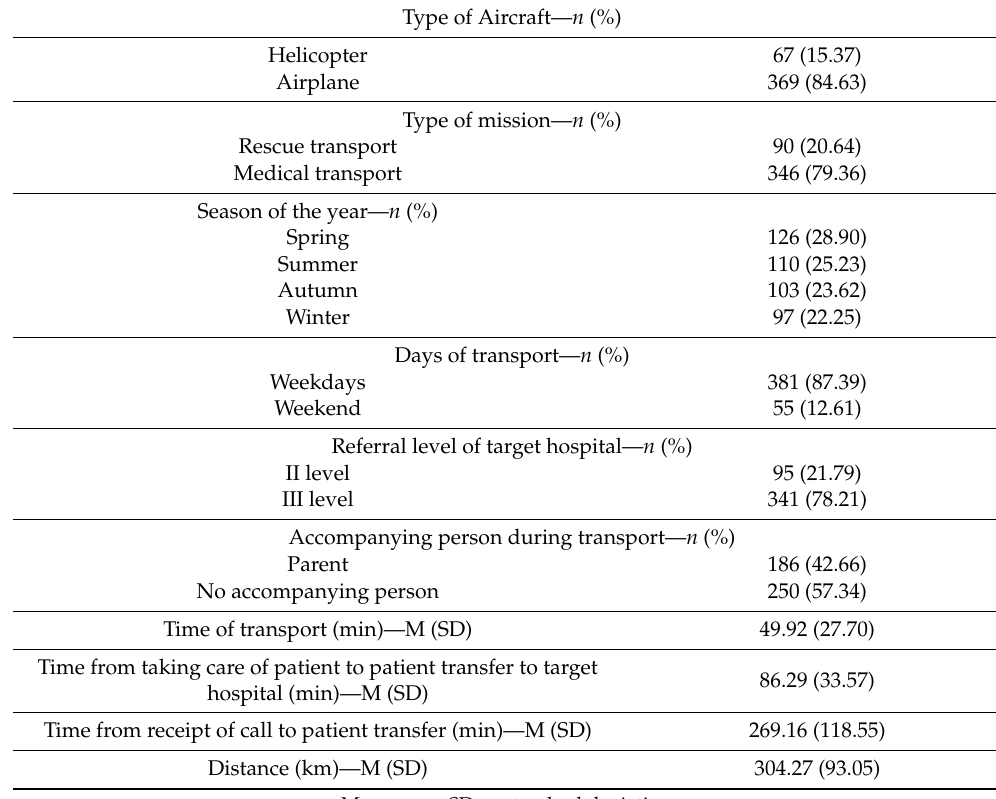
Table 2. Mission characteristics.